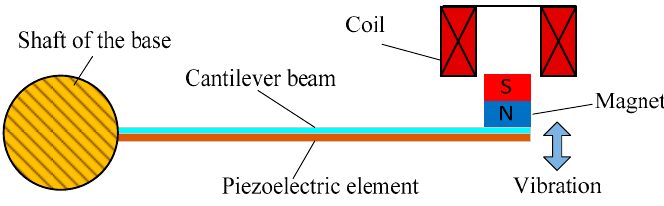
Figure 3. Structural diagram of single piezoelectric electromagnetic coupling cantilever beam.